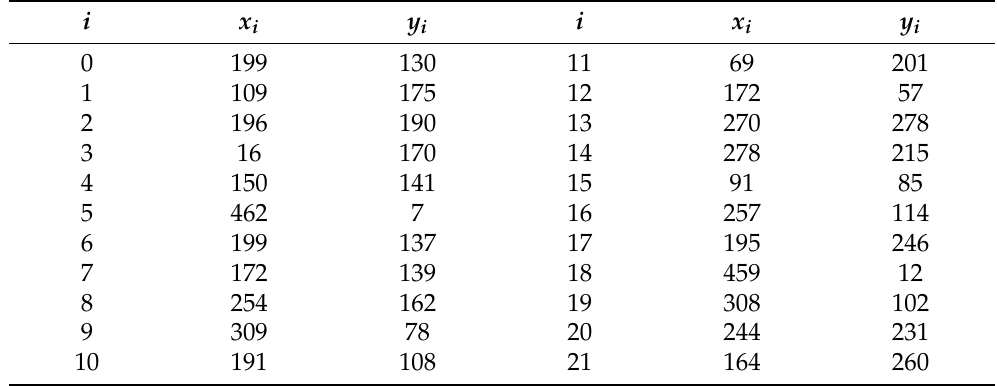
Figure A1. Location of the 21 convenience stores in Iguala. [46] Table A1. Instance